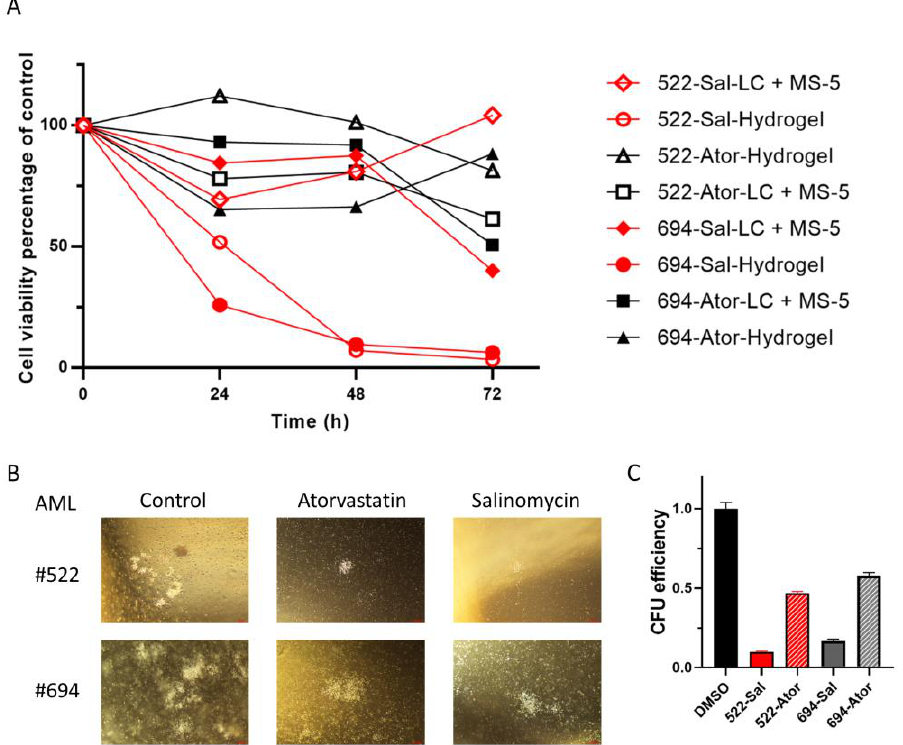
Figure 6. Atorvastatin and Salinomycin reduce the viability of AML patient samples in self-assembling peptide hydrogel (SAPH) culture and colony formation. ( A ) Line graphs displaying percentage survival of two AML patient samples (#522 and #694) treated with 5µM Atorvastatin (Ator) or 500 nM Salinomycin (Sal) for up to 72 h in standard co-culture (LC + MS-5) or 3D SAPH ( n = 3 for LC + MS-5; n = 4 for Hydrogel). ( B ) Representative phase-contrast images, and (C) efficiency as percentage of control ( n = 3) of colony formation in AML patient samples (#522 and #694) 14 days following treatment with 0.02% DMSO vehicle (Control), 5µM Atorvastatin, or 500 nM Salinomycin.